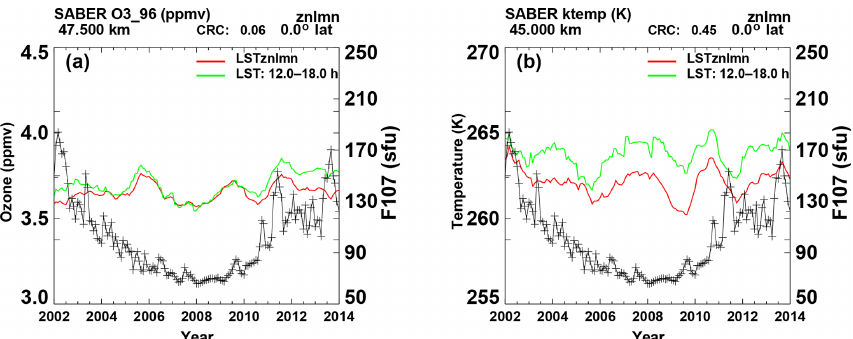
Figure 2. Ozone zonal mean mixing ratios ( a , red line, ppmv) from mid 2002 to mid 2014, 47.5km, 0 ◦ ; (b) , as in (a) , but for temperature (K) at 45km. The green lines represent how the data would vary if we simulated the variations with local time due to simulated orbital drifts of the NOAA operational satellites. Black lines ( + , right axis) show the corresponding monthly 10.7cm flux (sfu) provided by NOAA.